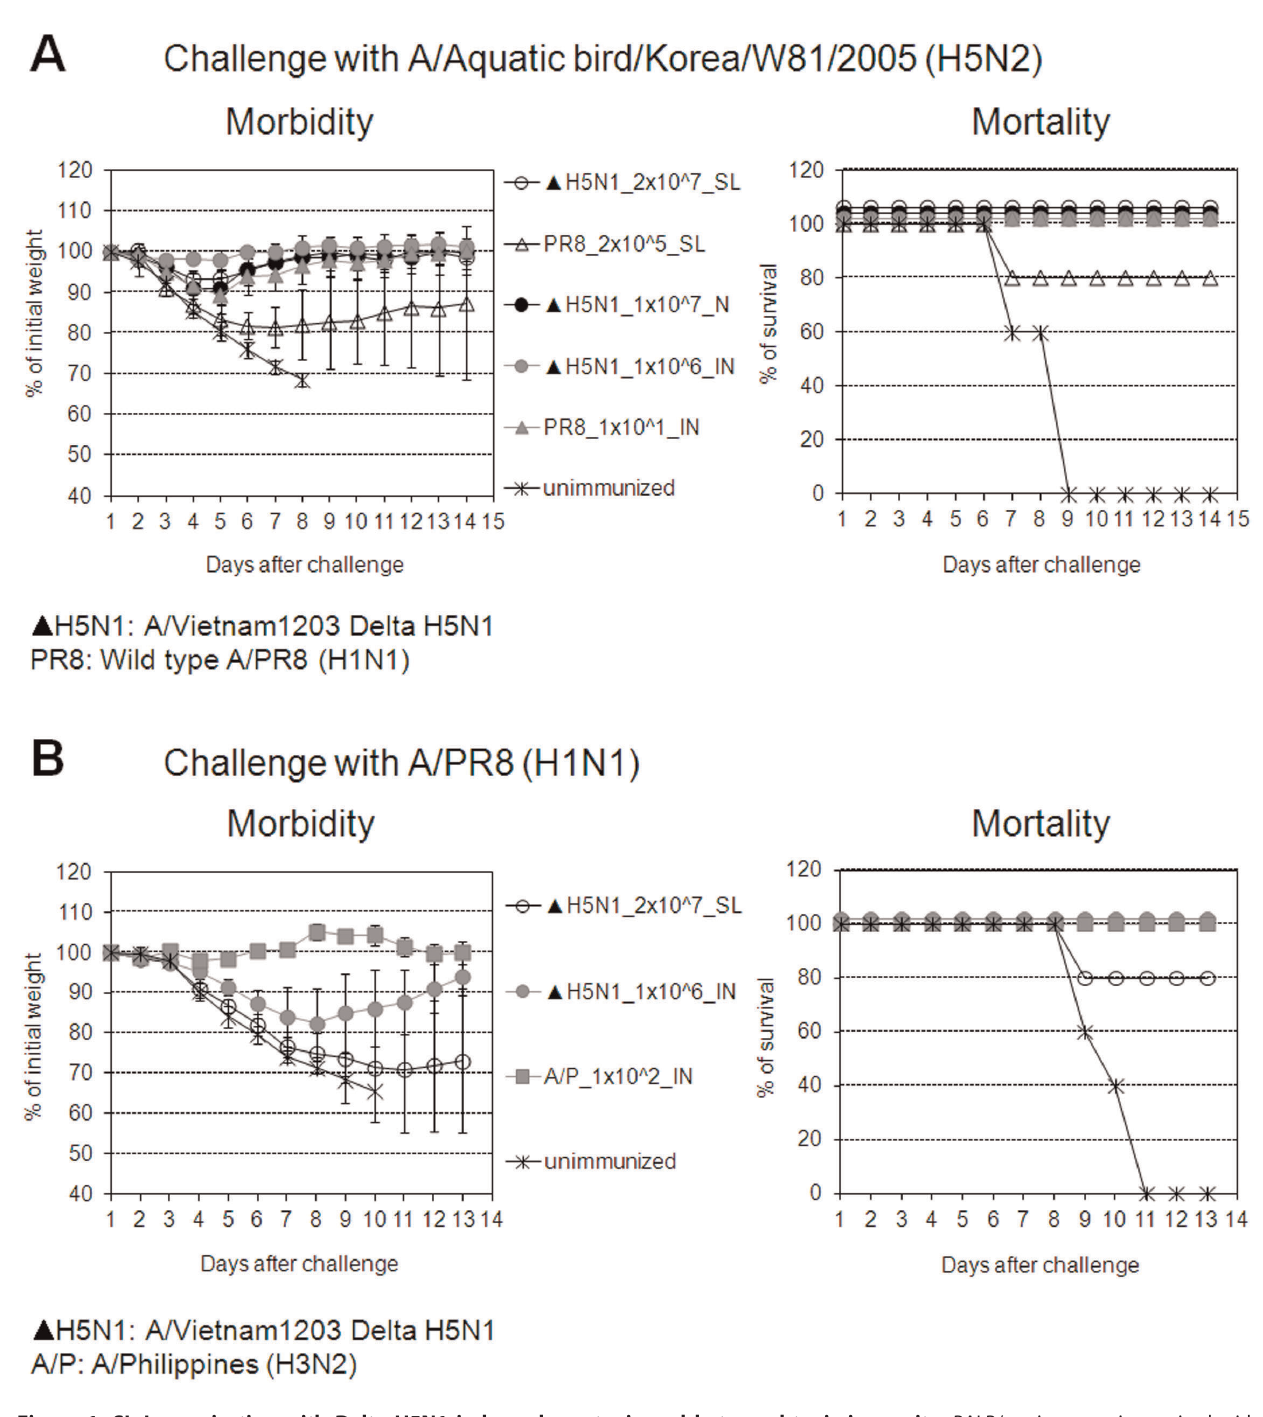
Figure 1. SL Immunization with Delta H5N1 induces homotypic and heterosubtypic immunity. BALB/c mice were immunized with different doses of Delta H5N1 ( m H5N1) or wt live virus A/PR8/34 (PR8) H1N1 via the sublingual (SL), nasal (N) or intranasal (IN) route. Four weeks later, the mice were IN challenged with homotypic A/Aquatic bird/Korea/W81/2005 (H5N2) (Fig. 1A) or heterosubtypic A/PR8 (H1N1) (Fig. 1B) as described in Materials and Methods. Morbidity and mortality were monitored daily for at least 3 weeks. Mean body weight 6 SD of each experimental group of 5–10 mice was determined at each indicated time point. Mortality is expressed as mean % 6 SD of mice that survived the challenge. The values are the means of 5–10 mice per group.